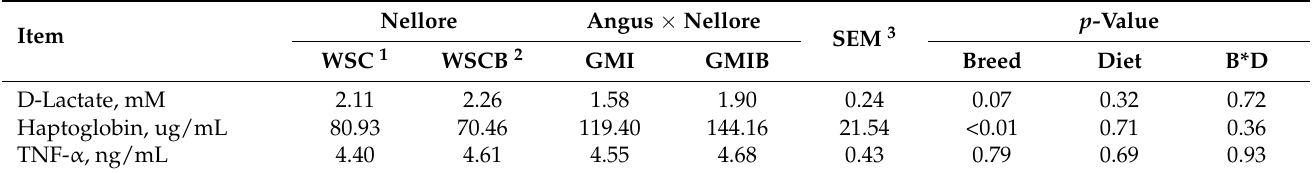
mineral, and vitamin supplement; and 6% sugarcane bagasse. 3 Standard Error of Means. 4 Intake during the behavior analysis period. Table 4. D-lactate concentration and immune response of Nellore and Angus × Nellore steers fed the ground whole shelled corn diet (WSC) or whole shelled corn with sugarcane bagasse (WSCB) diets on day 45 of the